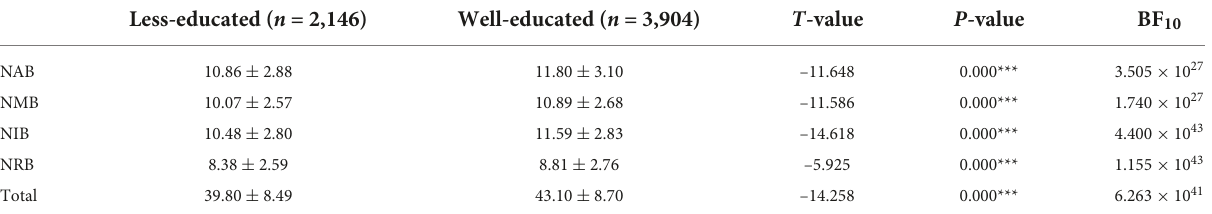
TABLE 9 Results for education level differences in negative cognitive processing bias scale